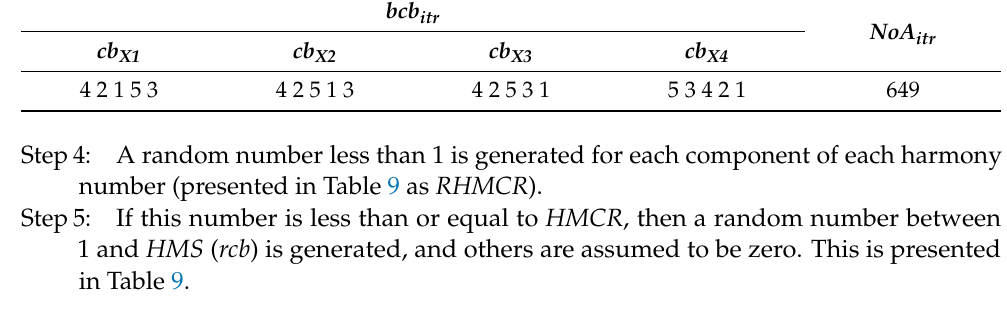
Table 9. RHMCR and rcb values.